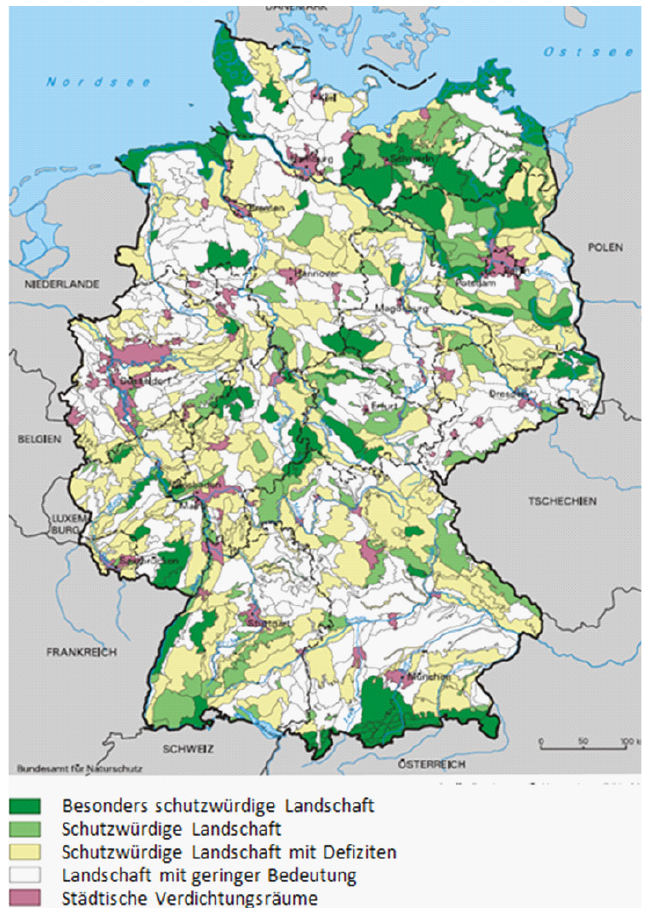
Figure 11: Nature protection-related assessment of German landscapes. Federal German Agency for Nature Conservation, 2012 (BfN,